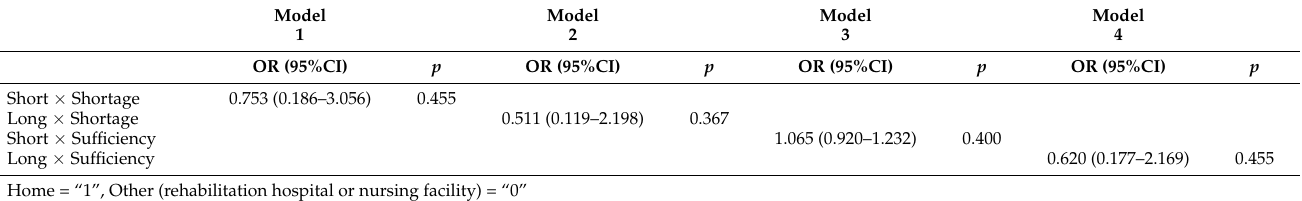
Table 4. Logistic regression analysis of home discharge